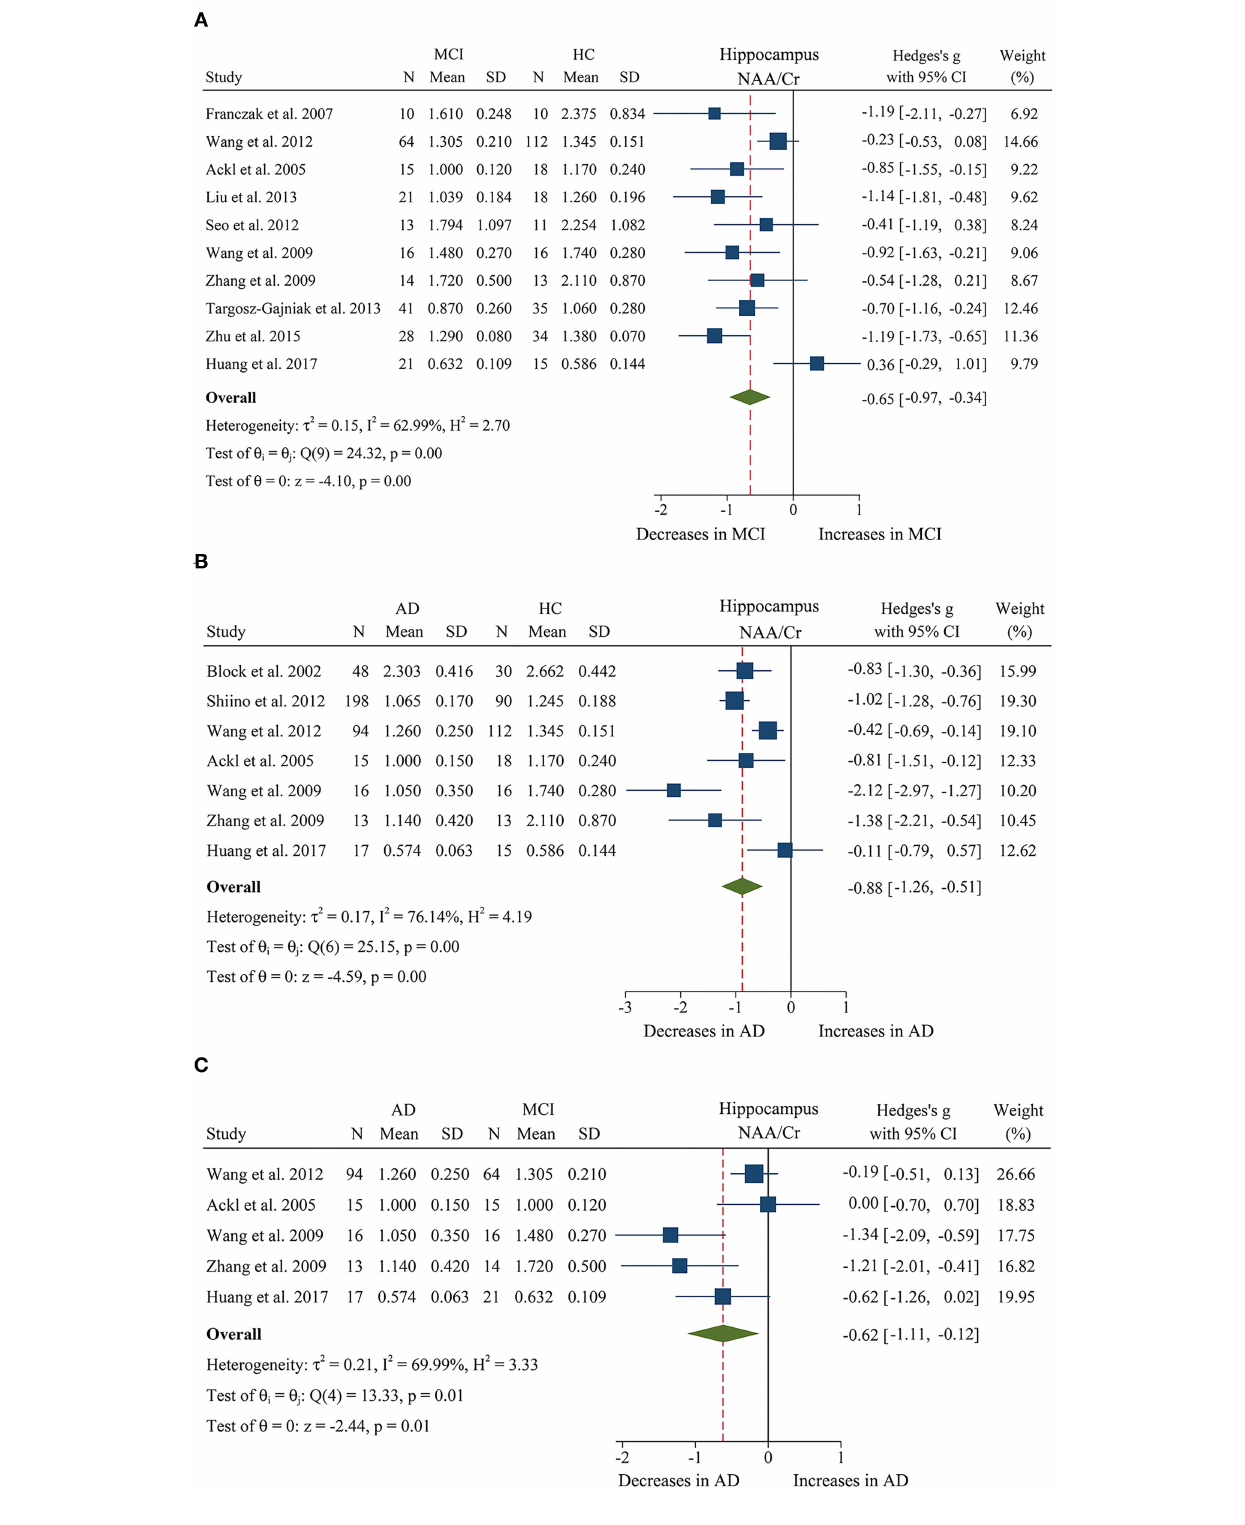
Frontiers in Aging Neuroscience |